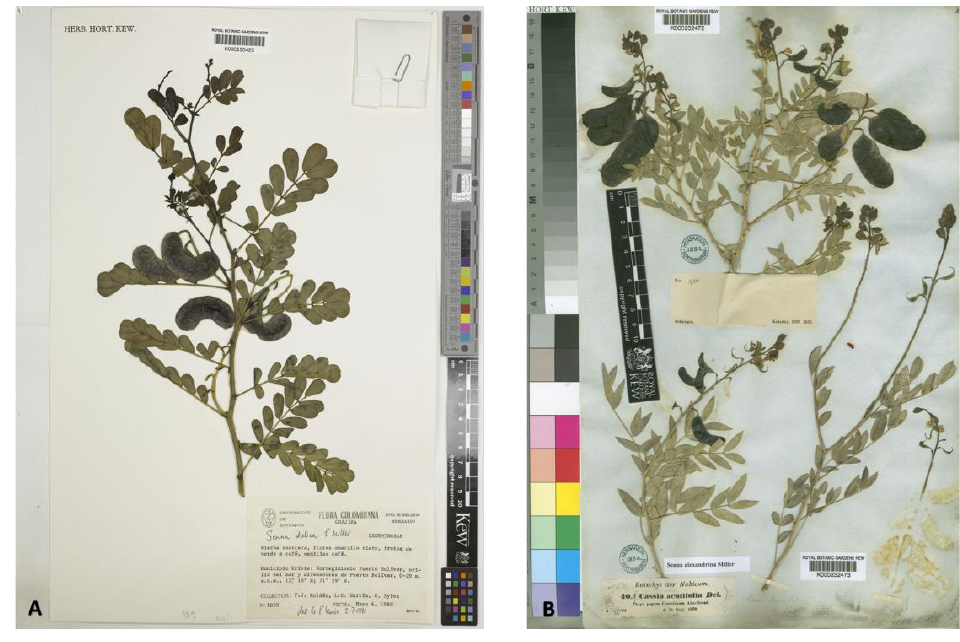
Figure 1. Senna italica ( A ) and Senna alexandrina ( B ) [5]. Table 1. The botanical characteristics and distribution of Senna italica and Senna alexandrina [5]. Senna italica Senna alexandrina Plant a subshrub, shrub, or